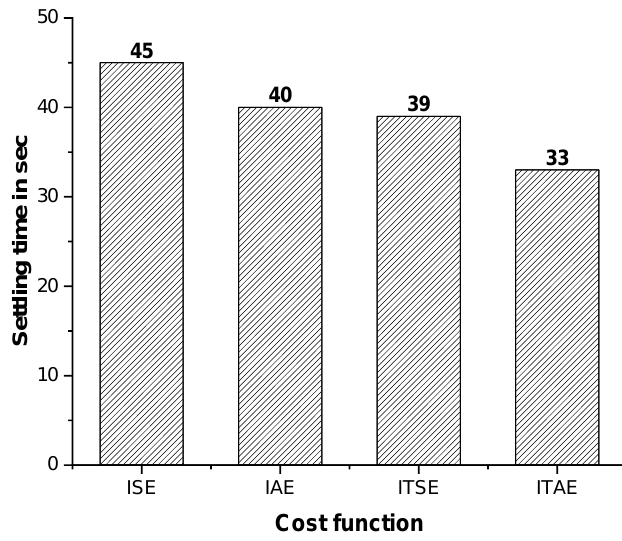
Figure 11. Bar chart comparison of settling time (PSO – PID controller).